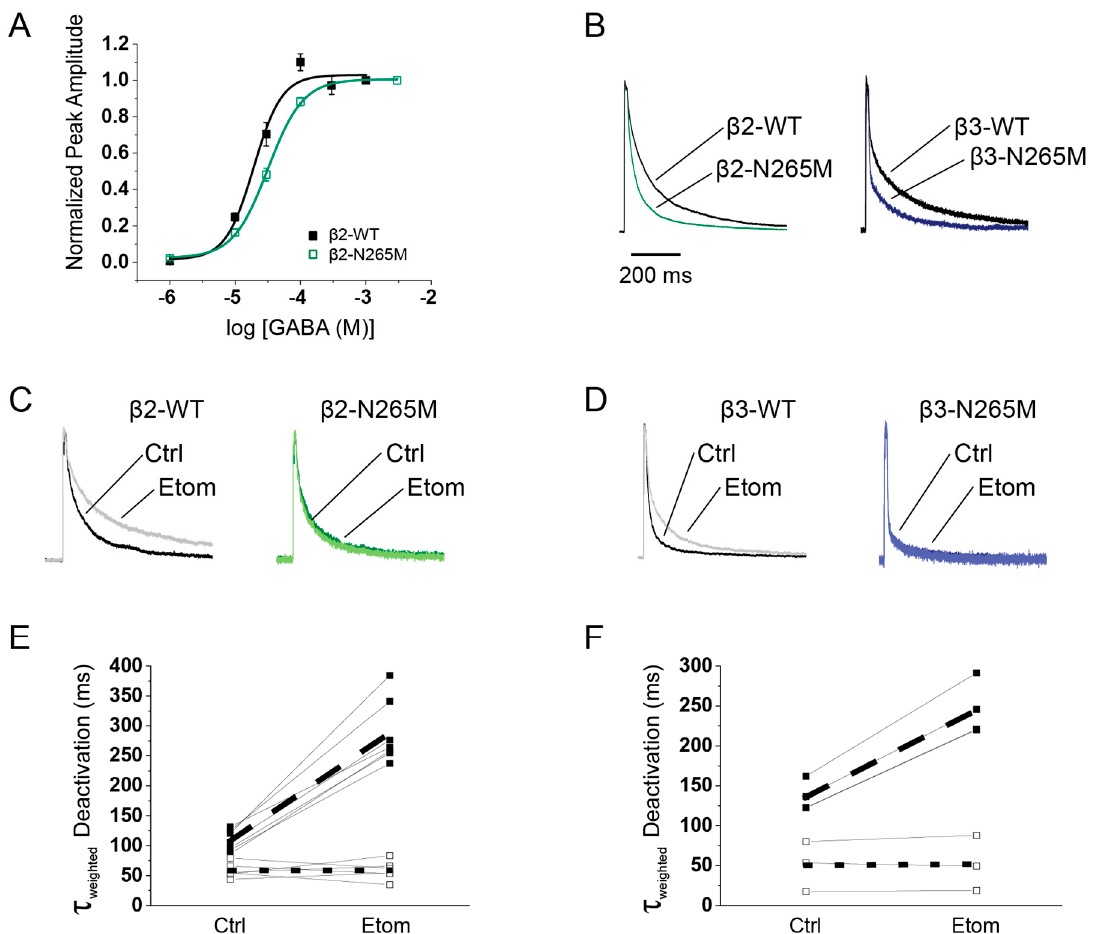
Figure 4. The N265M mutation altered intrinsic receptor characteristics and eliminated etomidate modulation. Recombinant α 5 β 2 γ 2L, α 5 β 3 γ 2L, α 5 β 2(N265M) γ 2L, and α 5 β 3(N265M) γ 2L receptors were expressed in HEK292 cells. Responses to agonist application were measured using patch clamp recording techniques. A multi-barrel application system was used to apply pulses of GABA in the presence and absence of etomidate. ( A ) The β 2-N265M mutation caused a rightward shift in the GABA concentration-response curve under drug-free conditions. Peak responses were normalized to the response to 3 mM GABA. ( B ) Examples of individual responses of α 5 β 2 γ 2L and α 5 β 2(N265M) γ 2L (left) and α 5 β 3 γ 2L and α 5 β 3(N265M) γ 2L (right) to brief pulses of 1 mM GABA. Traces were normalized to peak current amplitude. ( C , D ) Examples of individual responses to α 5 β 2 γ 2L and α 5 β 2(N265M) γ 2L (left) and α 5 β 3 γ 2L and α 5 β 3(N265M) γ 2L (right) to application of a 10 ms pulse of 1 mM GABA, in the absence (Ctrl) and presence (Etom) of 1 μ M etomidate. Responses were normalized to peak current amplitude. ( E ) 1 μ M etomidate slowed deactivation of α 5 β 2 γ 2L receptors (black squares, dashed line; p < 0.001), but not α 5 β 2(N265M) γ 2L receptors (open circles, dotted line; p = 0.47). ( F ) 1 μ M of etomidate slowed deactivation of α 5 β 3 γ 2L receptors (black squares, dashed line; p < 0.001), but not α 5 β 3(N265M) γ 2L receptors (open circles, dotted line; p = 0.93). Table 1. Activation and Deactivation Kinetics in GABA-stimulated Wild-Type and β 2/3-N265M Re- ceptors.